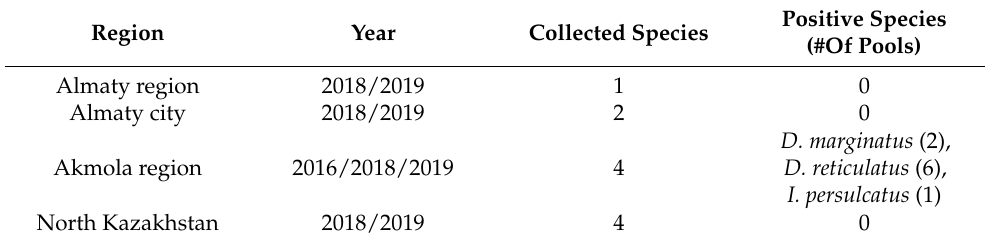
Table 1. Results of OHFV real-time RT-PCR screen in tick pools of D. marginatus, D. reticulatus , D. niveus and I. persulcatus (in total, 1058 tick pools) from Almaty city (seven trapping sites), Al- maty region (five trapping sites), Akmola region (six trapping sites) and North Kazakhstan (nine trapping sites). Region Year Collected Species